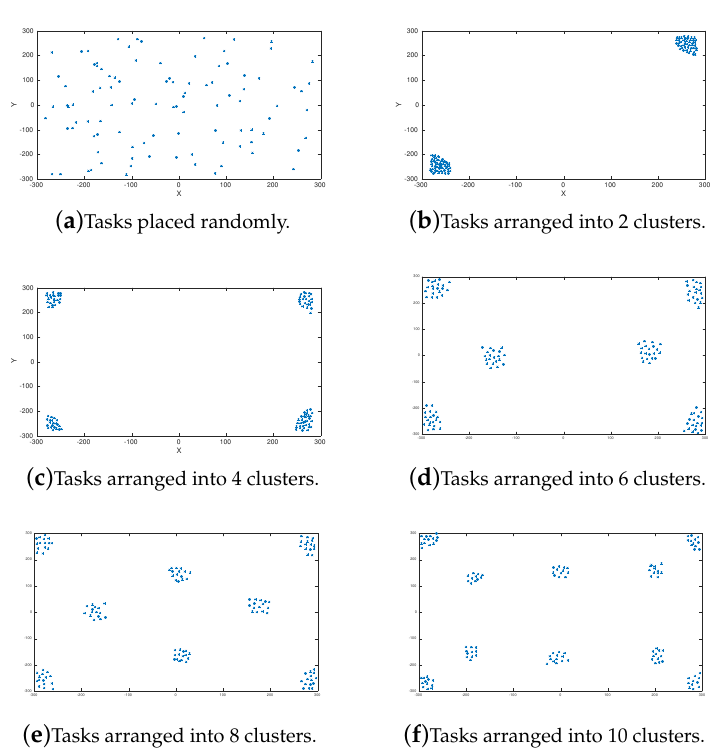
( f ) Tasks arranged into 10 clusters.